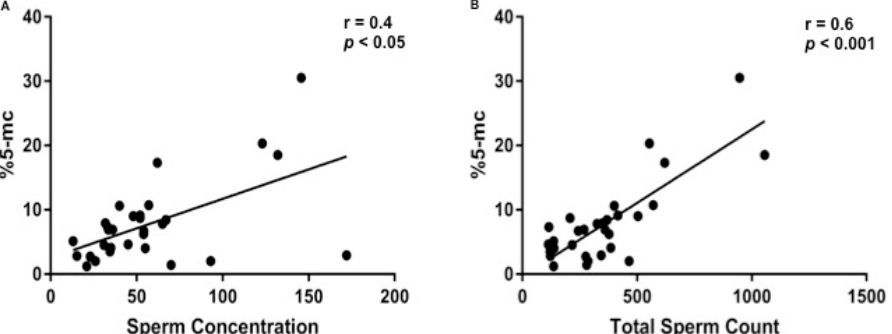
Figure 1. Relationship between %5-mc and sperm concentration ( A ) and total sperm count ( B ) in dogs population. Spearman’s correlation analysis shows a significant regular positive correlation between %5-mc and sperm concentration (r = 0.4; p < 0.05) ( A ) and a significant strong positive correlation between %5-mc and total sperm count (r = 0.6; p < 0.001) ( B ).